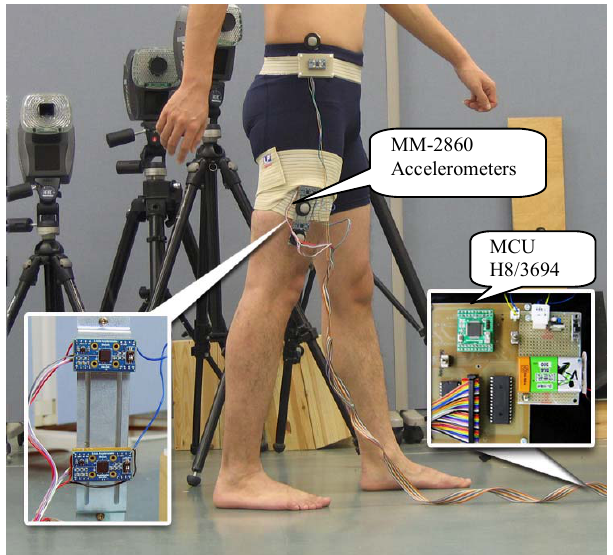
Fig.9 Experiment for the lower limb orientation using the developed wearable system